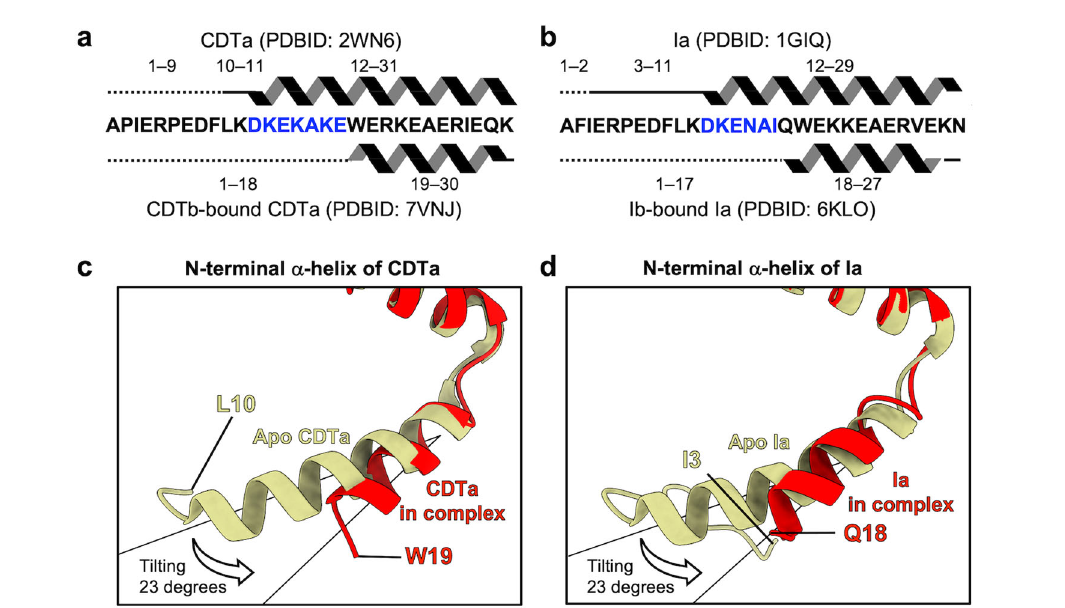
Fig. 5 | N-terminal α -helix conformationalchangesinCDTa and Ia. a Secondary structures of the CDTa crystal structure in the apo state (PDB ID: 2WN6) and the CDTa cryo-EM structure in the CDTb-pore complex (PDB ID: 7VNJ). b Secondary structuresoftheIacrystalstructureinthe apostate (PDBID:1GIQ)andthe Iacryo- EM structure in the complex with Ib-pore (PDB ID: 6KLO). In both ( a ), ( b ), the